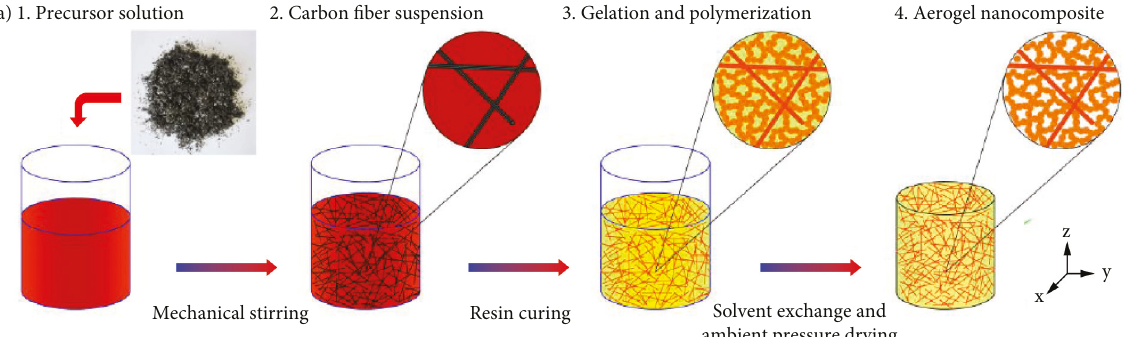
Figure 14: Schematic diagram for the preparation of fiber reinforced aerogel